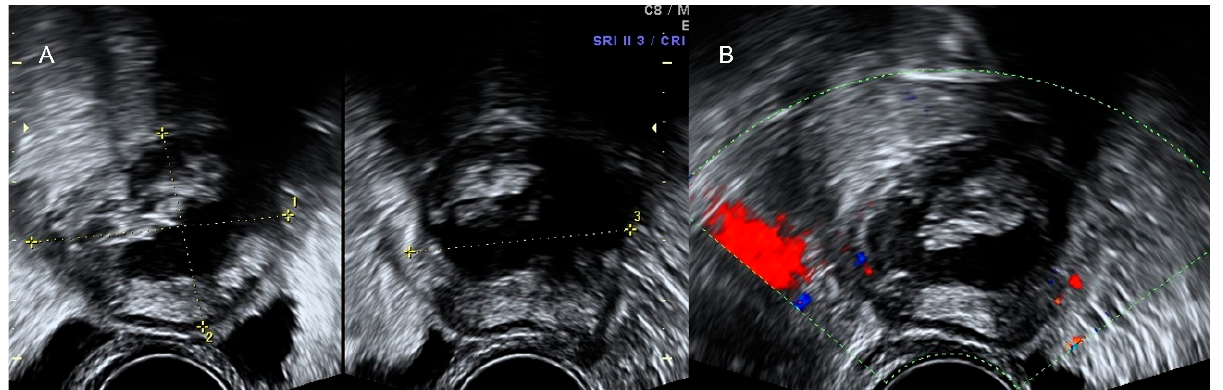
Figure 28. Transvaginal ultrasound sagittal view of the pelvis shows the uterus and the cervix and adjacent to the posterior wall, a cystic lesion with diffuse echoes, and hyperechoic images with acoustic shadows consistent with a pilonidal cyst ( A – C ). Power Doppler shows absence of vascularization ( C ).